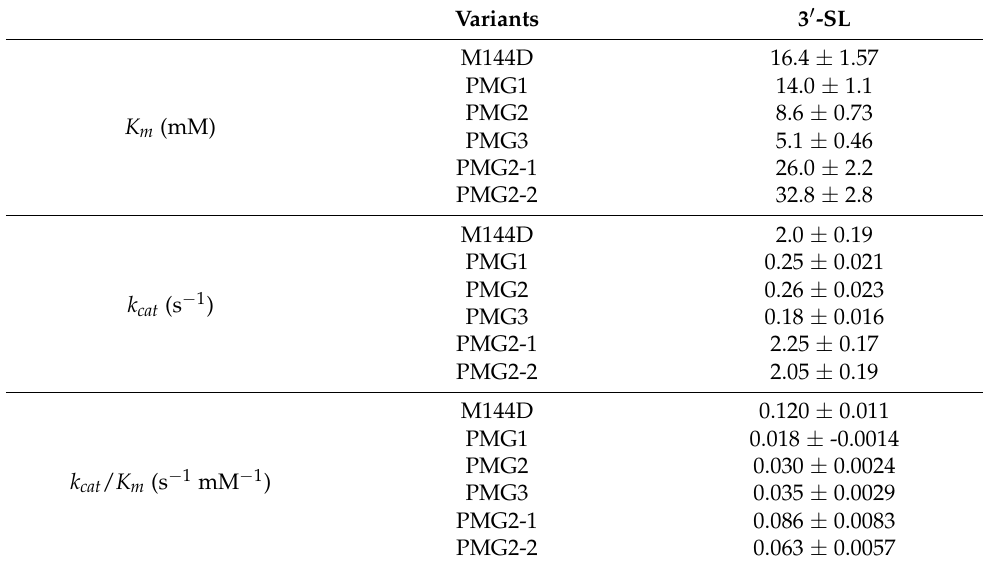
Table 4. Apparent kinetics of the α 2,3-sialidase activities of M144D and